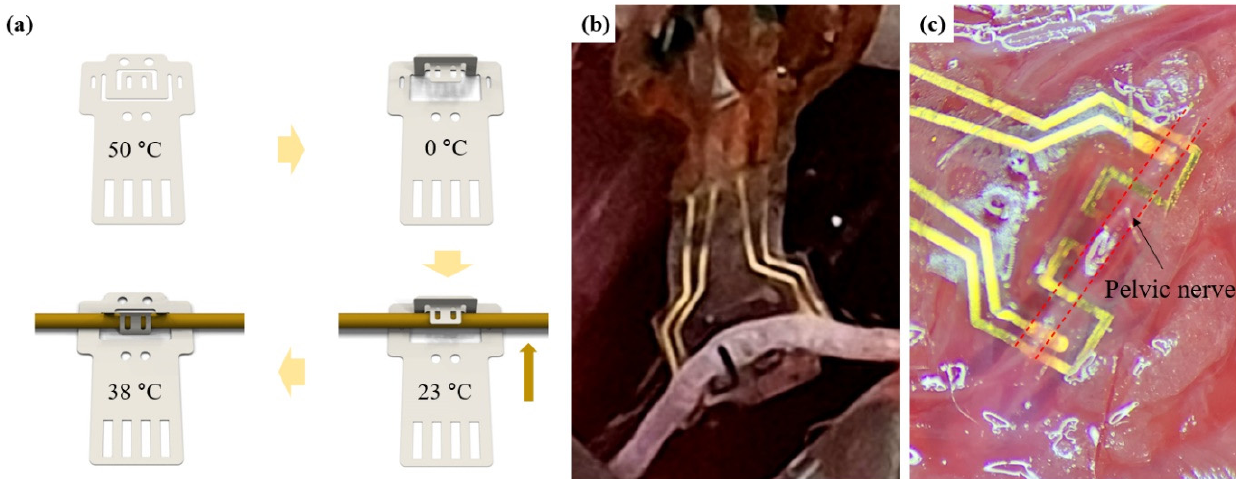
Figure 5. Functional implantation in bench up and in vivo: ( a ) Schematic of DCNI implantation process; ( b ) CPN implan- tation of the DCNI; and ( c ) PN implantation of the DCNI.